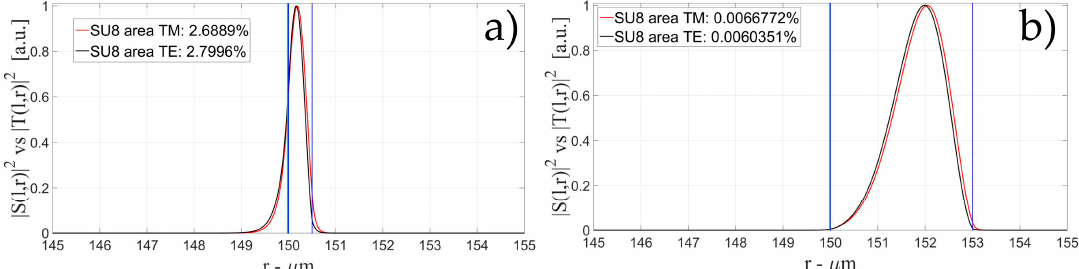
Figure 4. Electric field distribution of WGMs along the radial direction for TE (| S ( l,r ) | 2 ) and TM (| T ( l,r ) | 2 ) modes for the 1st radial order: ( a ) for a wall of about 500 nm (maximum sensitivity); and ( b ) for a wall of about 3 μ m (minimum sensitivity). Legends show the fraction of | S ( l,r ) | 2 and | T ( l,r ) | 2 inside the biological layer.